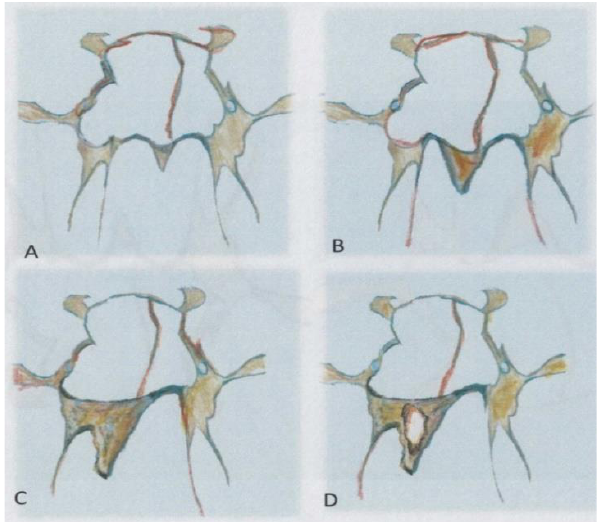
Figure 4. ( A ) Symmetric rostrum; ( B ) Asymmetric rostrum, ( C ) Eccentric, and Dysmorphic rostrum, ( D ) Pneumatized rostrum .